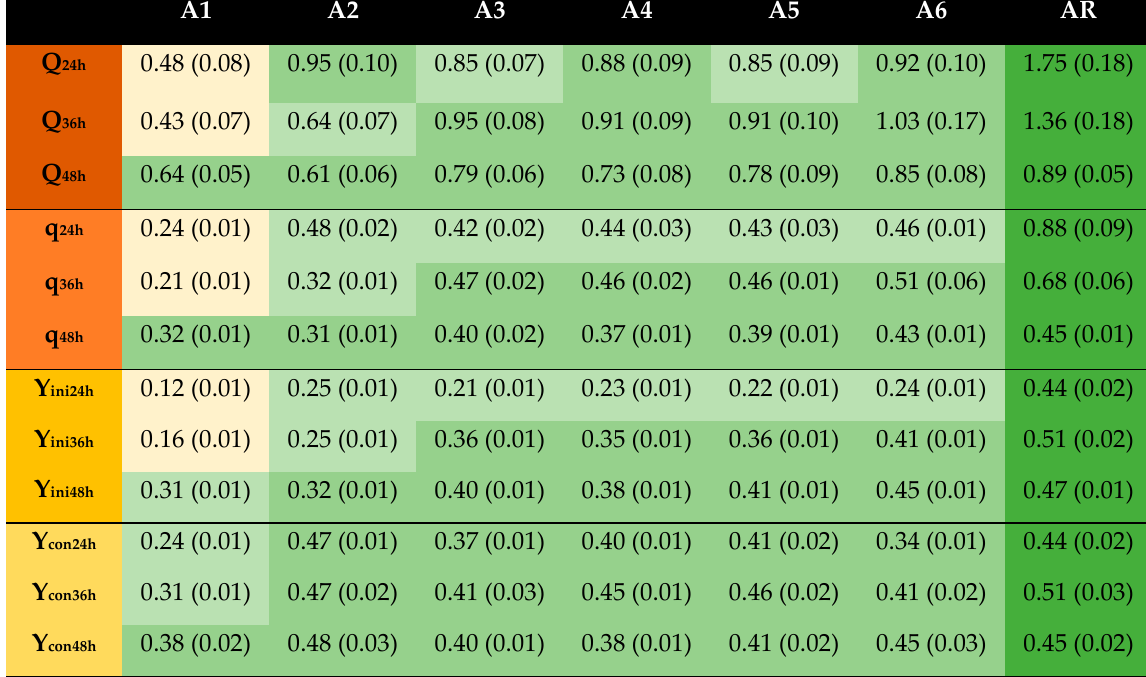
Figure 1. Fermentation results from first experimental series (A1–AR). Codes refer to conditions detailed in Table 1. Calculations are based on the results obtained after 24 h, 36 h, and 48 h of fermentation. Standard deviations are shown in parentheses. Color scheme: